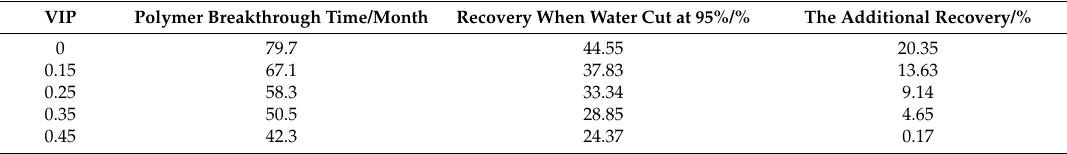
Table 3. List of materials required for experiments.